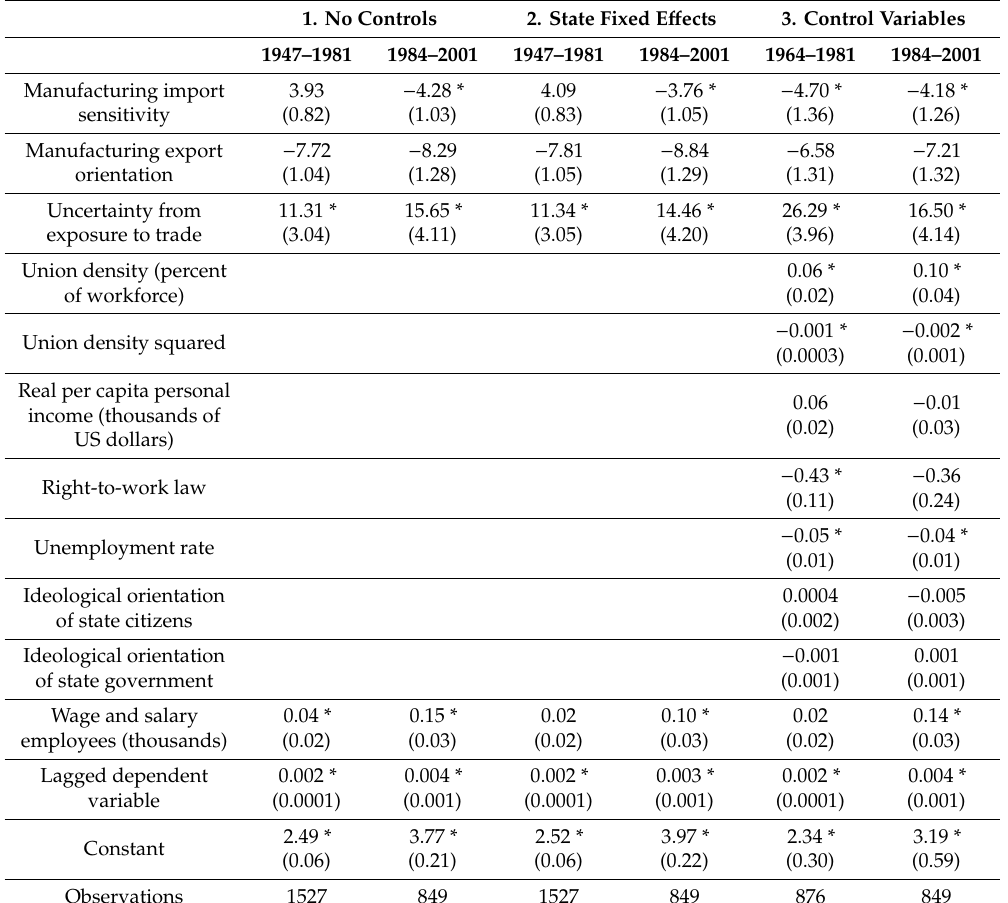
Table A3. Models from Table 1 with Alternative Indicator of Trade-Related